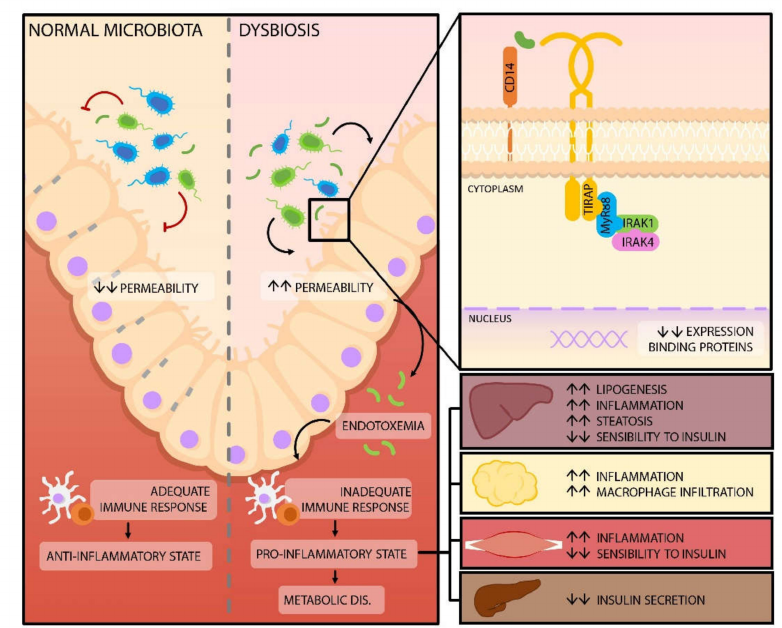
Figure 1. Modification of the intestinal barrier permeability. Dysbiosis, as a result of high fat intake, leads to a higher concentration of lipopolysaccharides (LPS). When LPS interacts with toll-like 4 receptors, a signaling cascade is triggered, which results in a decrease of binding proteins and, therefore, an increase in gut permeability. The resulting endotoxemia generates changes in the immune response of the host, favoring a pro-inflammatory state in di ff erent organs and tissues, which can lead to the development of metabolic diseases, such as Diabetes Mellitus. Abbreviations: CD14: Cluster of di ff erentiation 14; TIRAP: Toll-Interleukin-1 receptor domain-containing adapter protein; MyR88: Myeloid Di ff erentiation Gene 88; IRAK: Interleukin 1 Receptor Associated